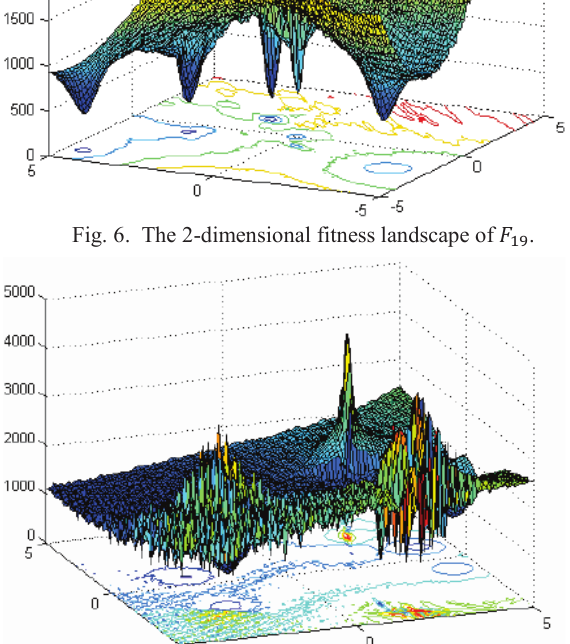
Fig. 7. The 2-dimensional fitness landscape of